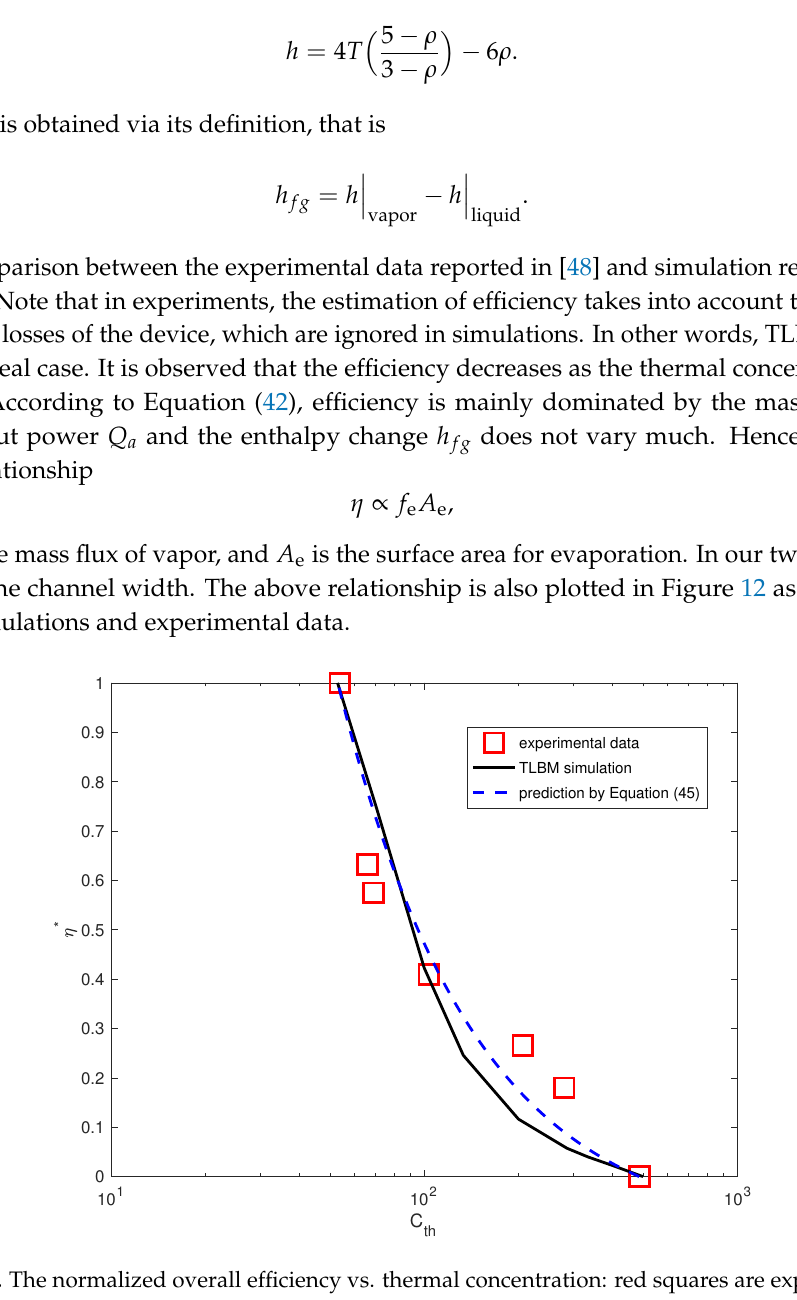
Figure 12. The normalized overall efficiency vs. thermal concentration: red squares are experimental data reported from [48]; black solid line represents simulation results; efficiency is normalized for comparison, specifically, η ∗ = 1 corresponds to C th = 53, and η ∗ = 0 corresponds to C th =